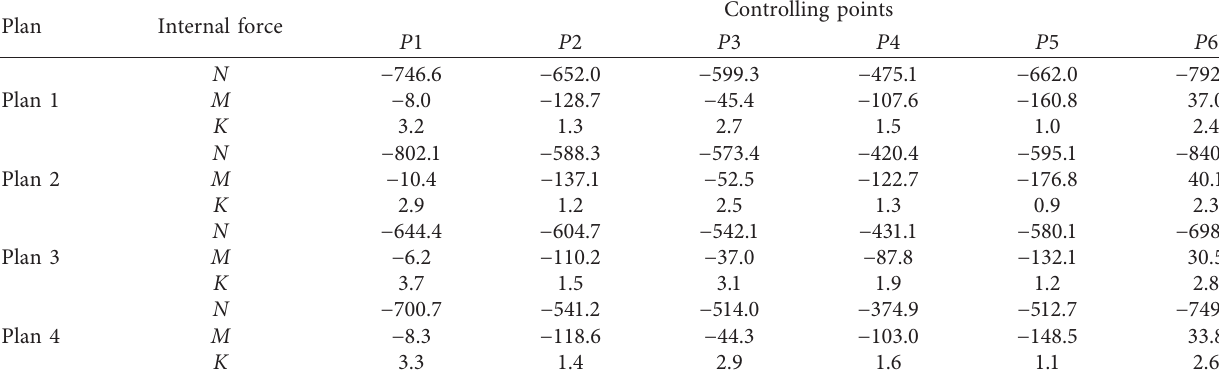
Table 5: Safety factor of controlling points of initial support of different